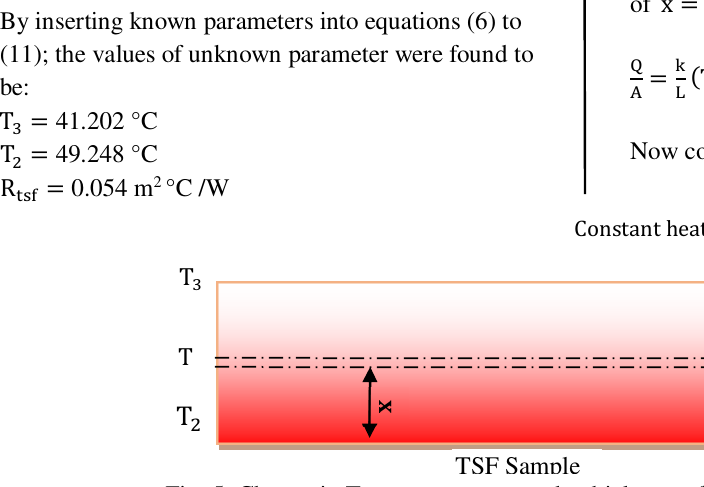
Fig. 5: Change in Temperature across the thickness of TSF as homogenous